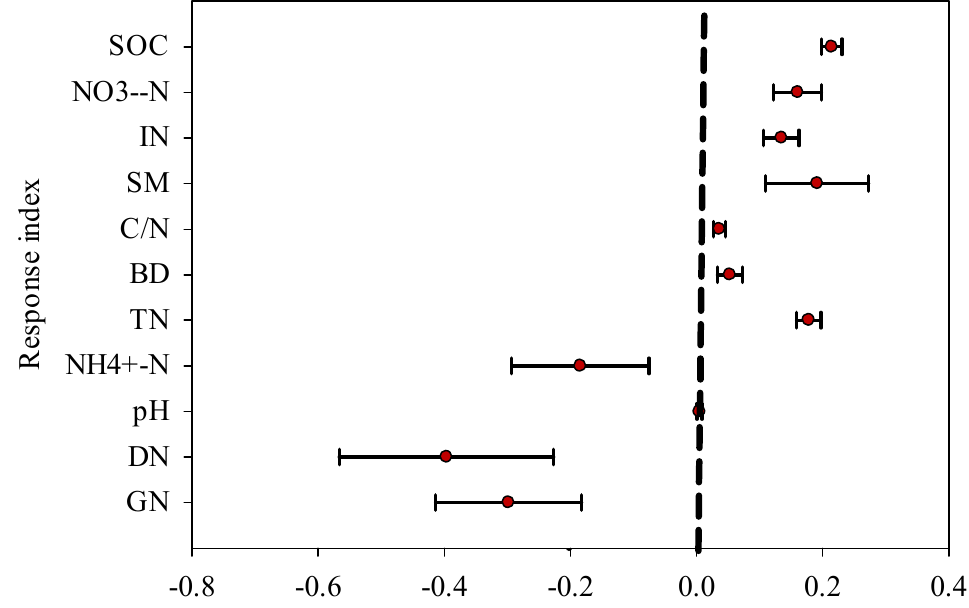
Figure 1. Gross nitrification (GN), denitrification (DN), and soil physical and chemical properties as responses to grazing.